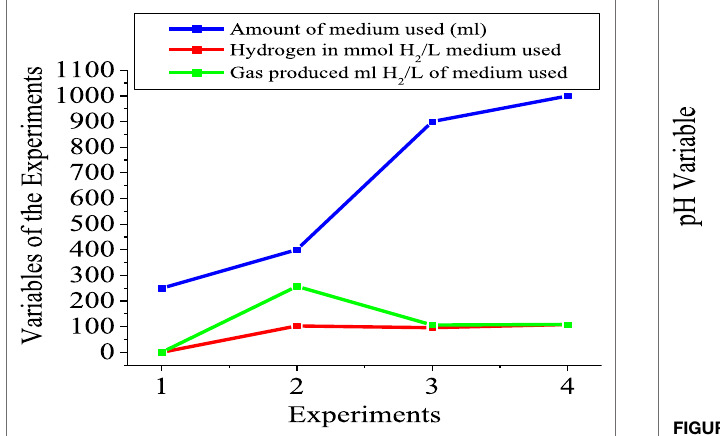
FIGURE 5 | Amount of medium and hydrogen variables of the experiments.